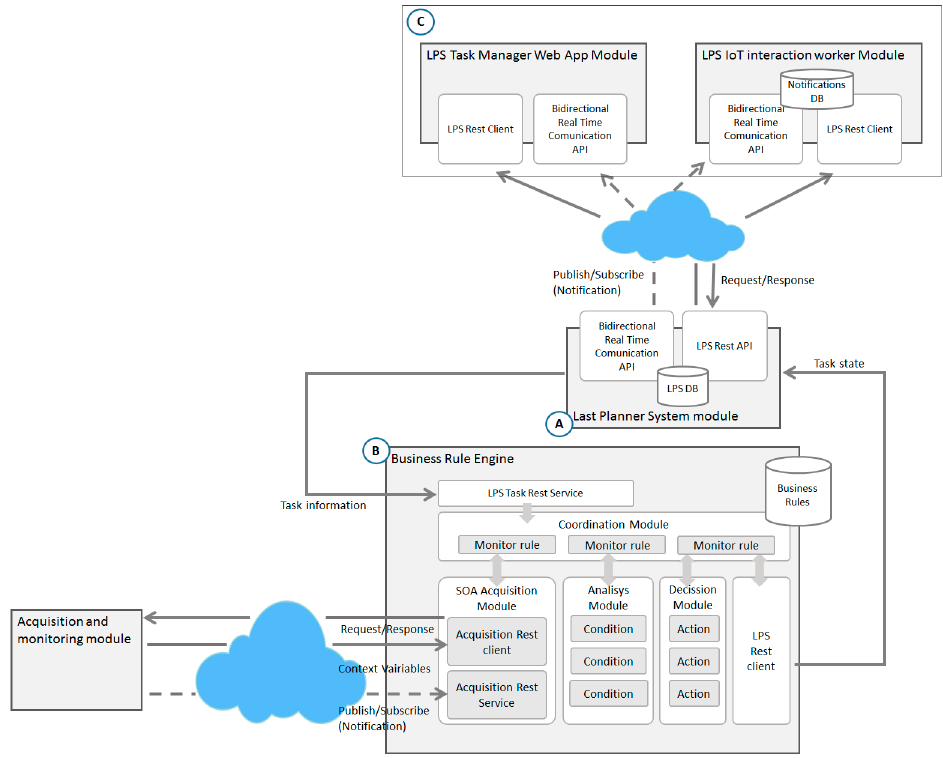
Figure 9. Architecture for LPS module, Business Rule Engine and interaction modules.